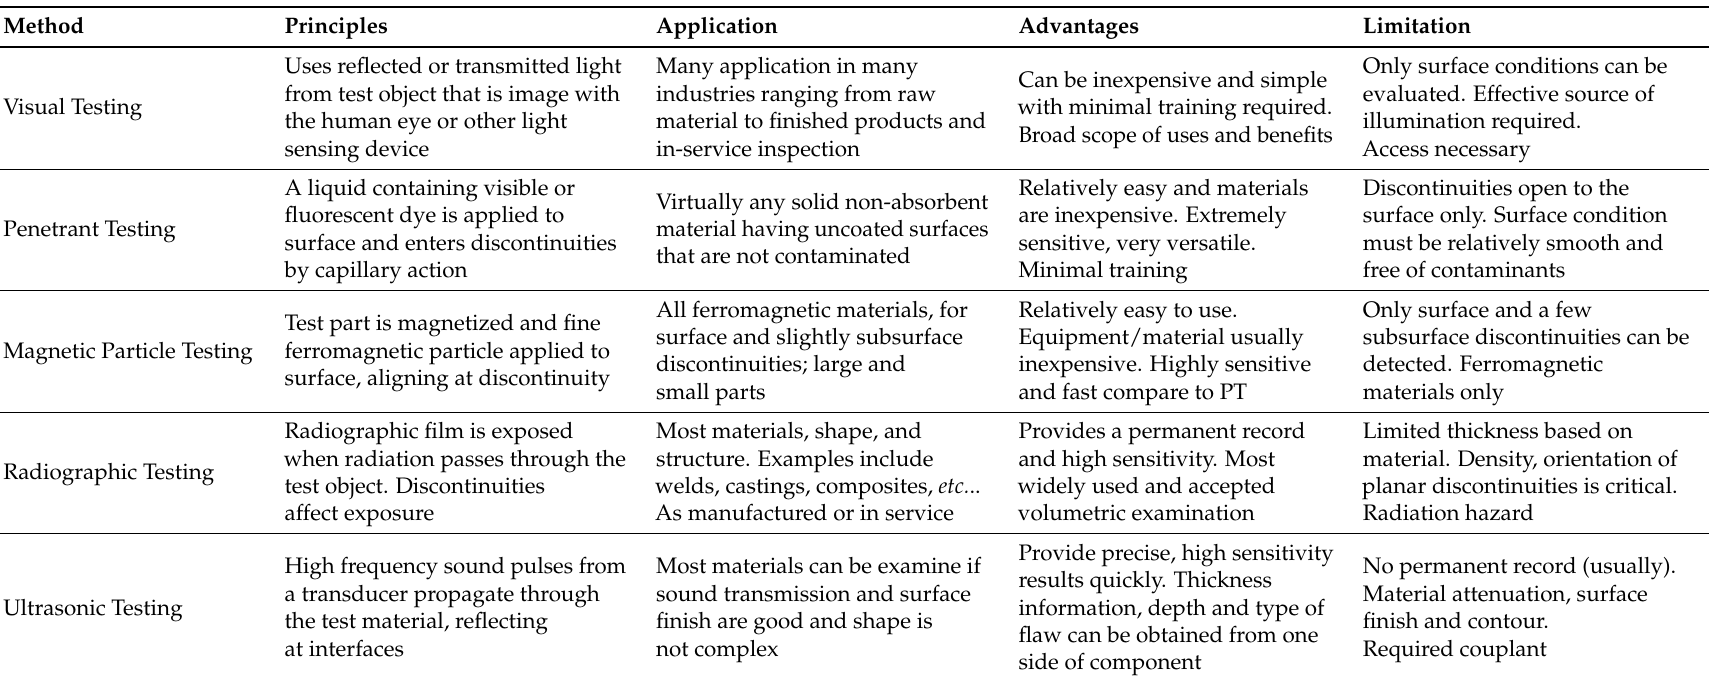
Table 1. Major NDT Methods—A comprehensive overview